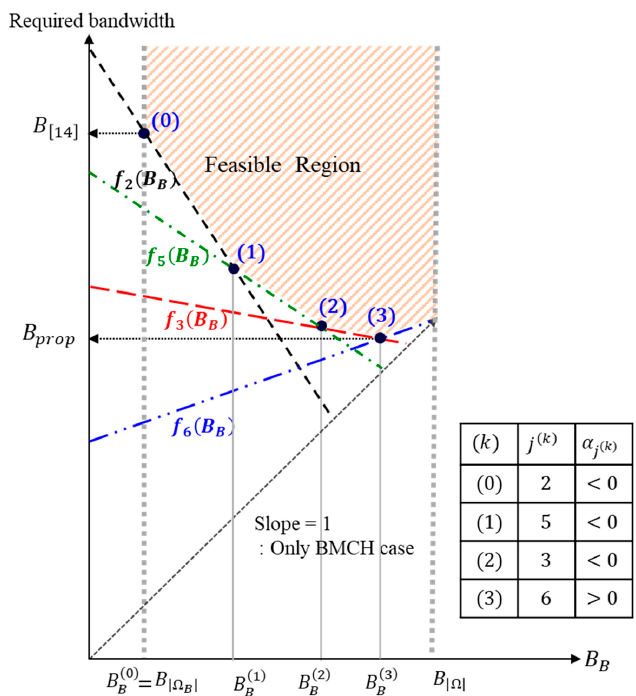
Figure 2. The proposed iterative algorithm and 𝑓 (cid:3037) (𝐵 (cid:3003) ) .